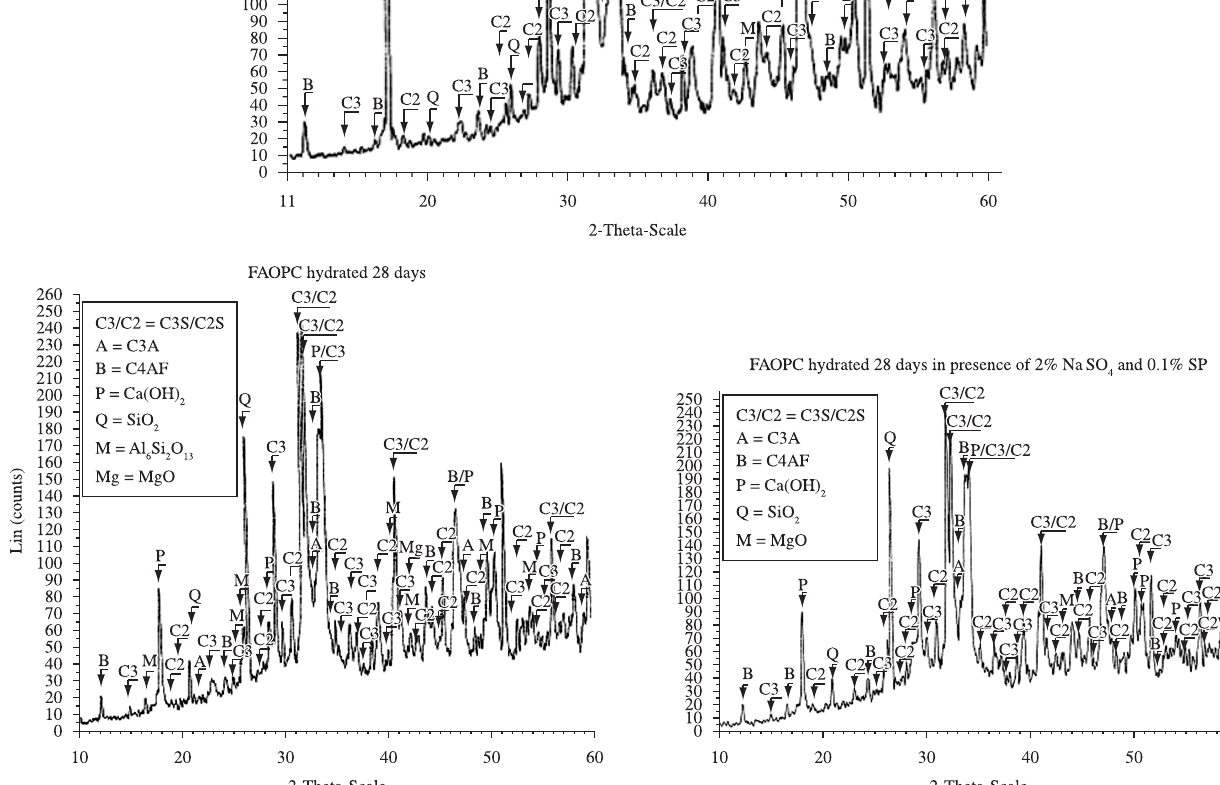
0.1 wt. (%) superplasticizer and 2.0 wt. (%) sodium sulphate.